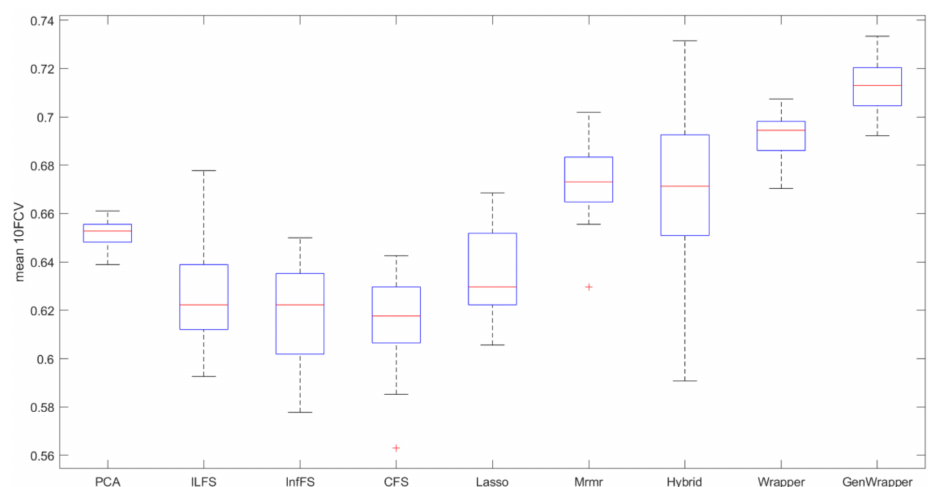
Figure 9. Bar graph comparison for the best models (SVMs trained on the optimum number of selected features per case). Red lines correspond to the mean 10FCV, blue boxes visualize the standard deviation of the obtained accuracies, dashed black lines show the min–max range and the red crosses depict outliers (if any).